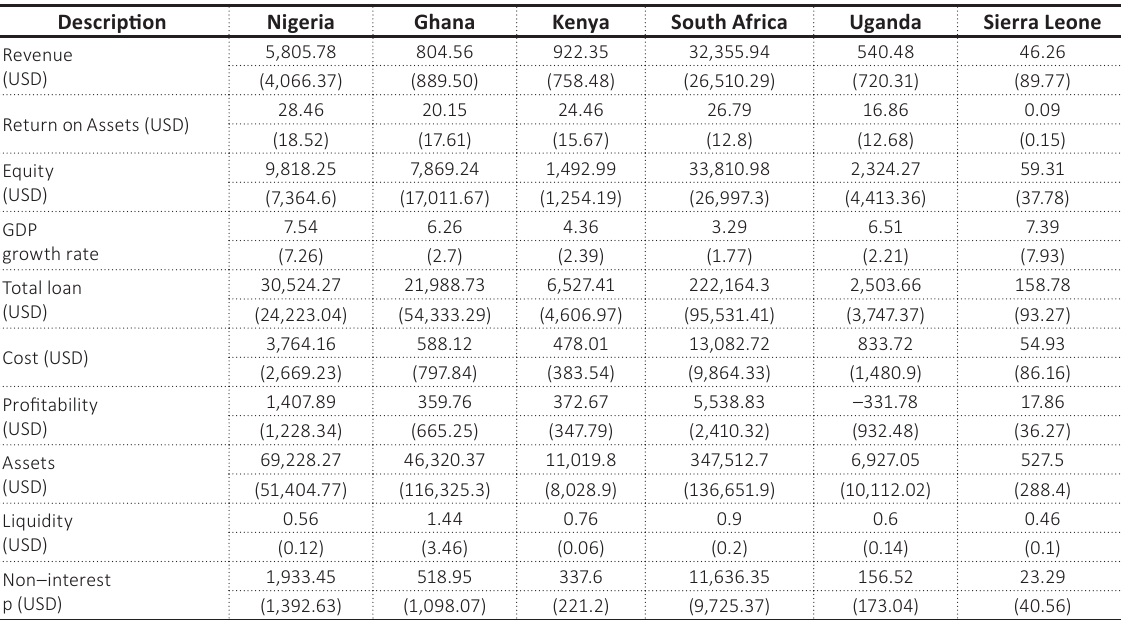
Table A2. Summary statistics of variables employed for selected